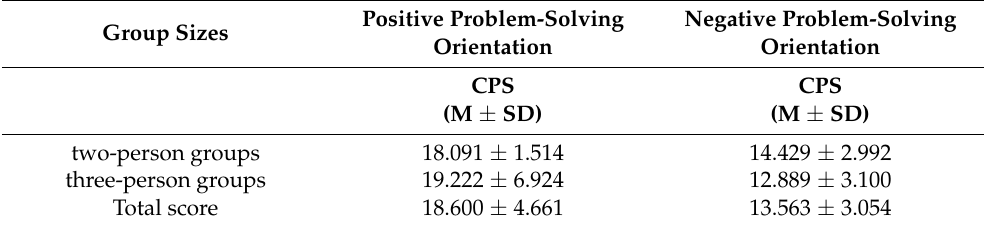
Table 1. CPS scores under different problem-solving orientations and group sizes (M ± SD). Group